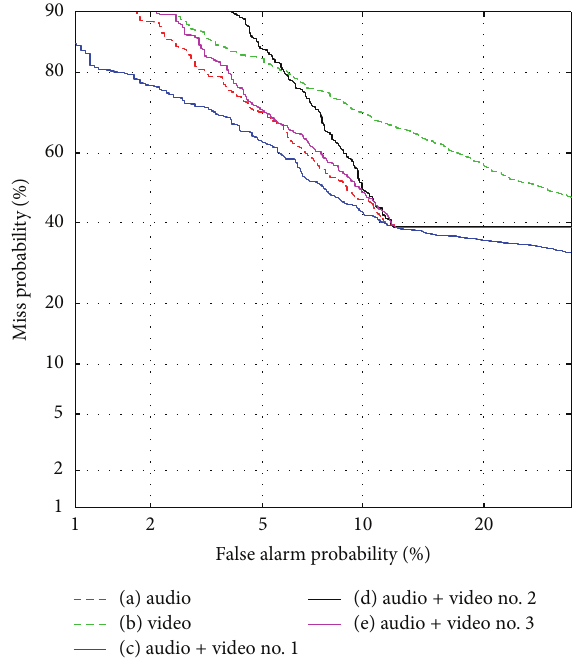
Figure 16: DET plot of voice activity detection performance for Dataset 1: solid lines—audio + video combinations, dashed lines— audio and video systems individually. VAD based on both audio and video modalities (audio + video no. 1) indicates better performance than audio-only VAD for most of the operating points.